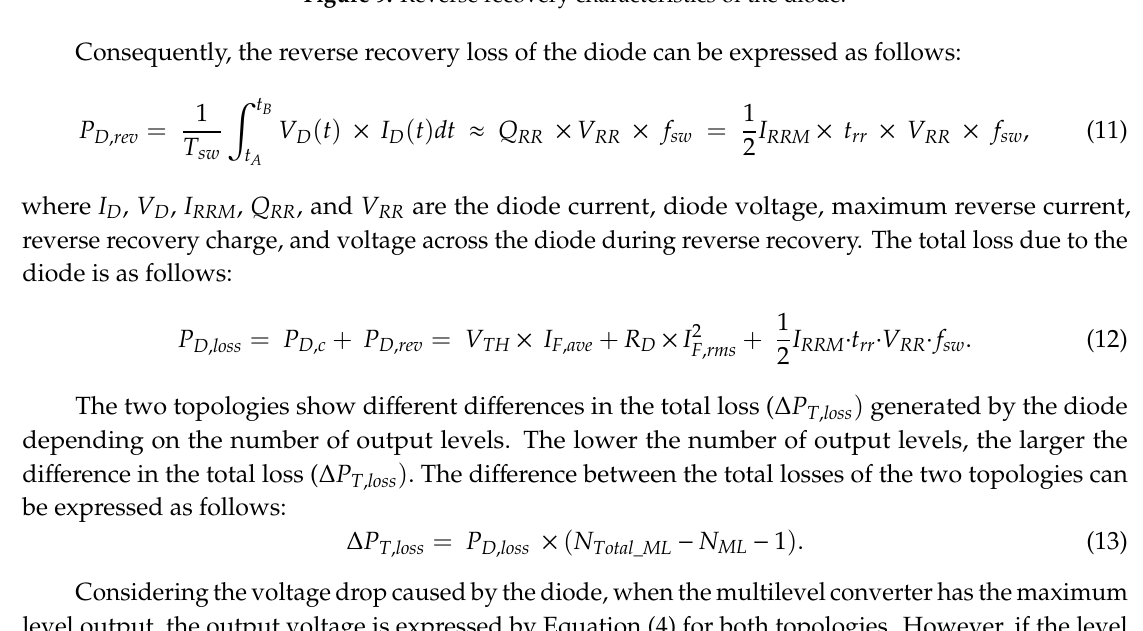
Figure 9. Reverse recovery characteristics of the diode.